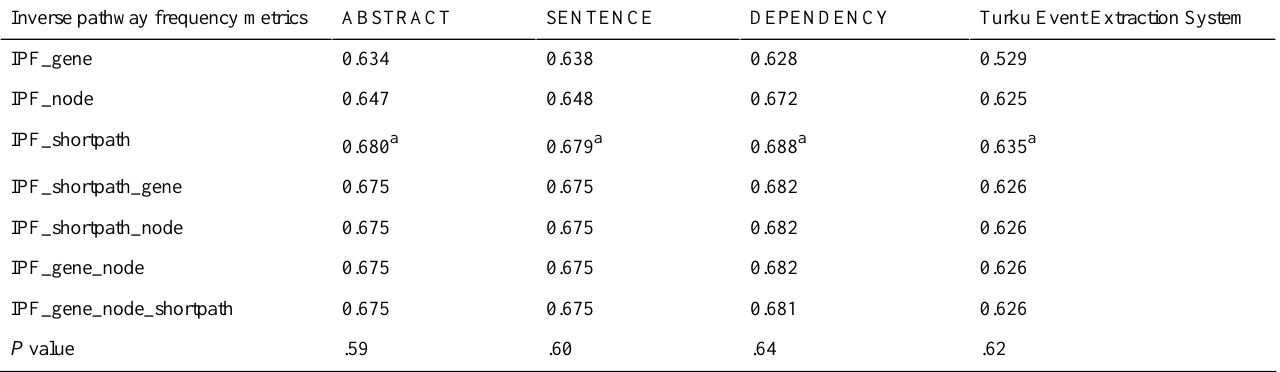
Table 2. Comparison of the areas under the cumulative percentage curve for the pathway-enriched methods based on the known rapamycin-related